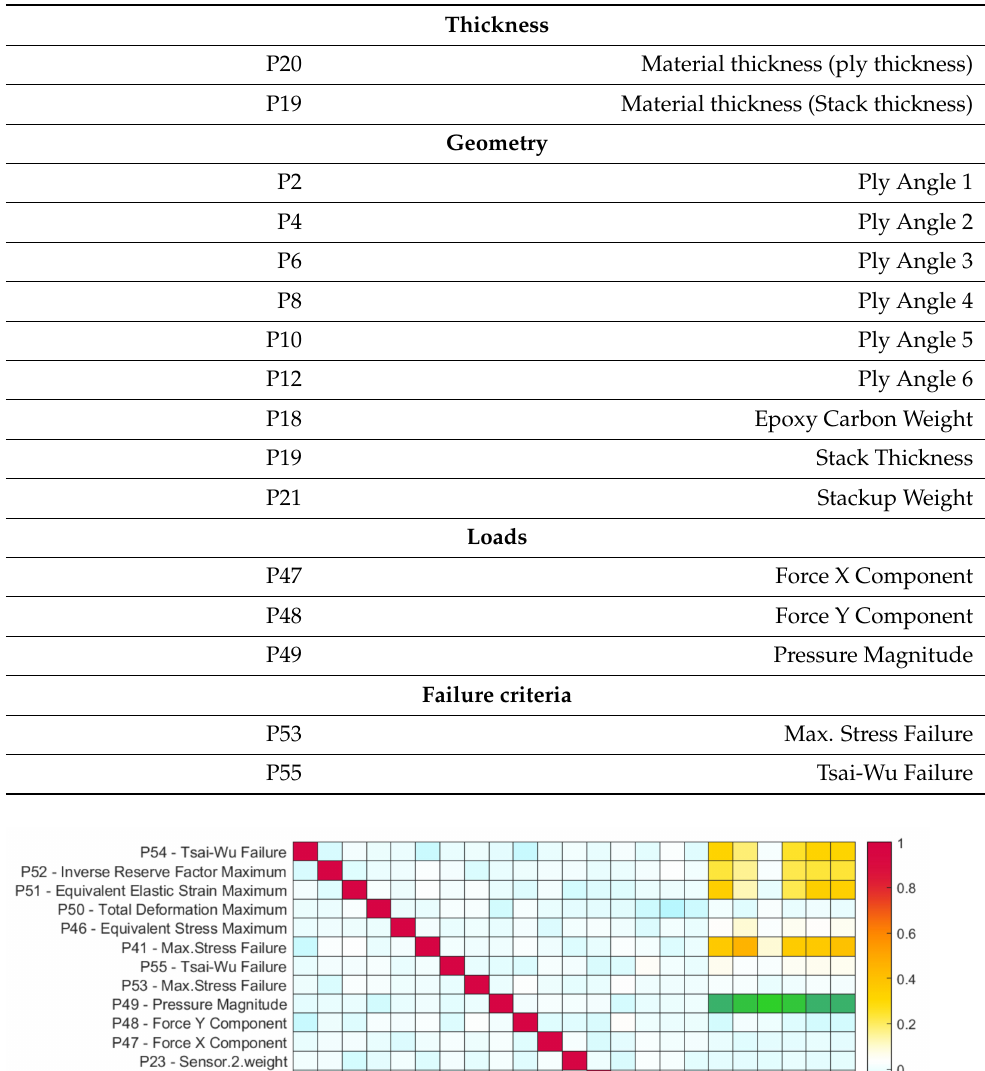
Table 3. Correlation Parameters.